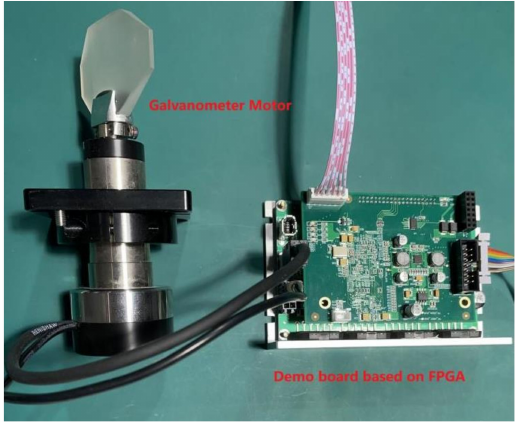
Figure 3. The experimental platform.